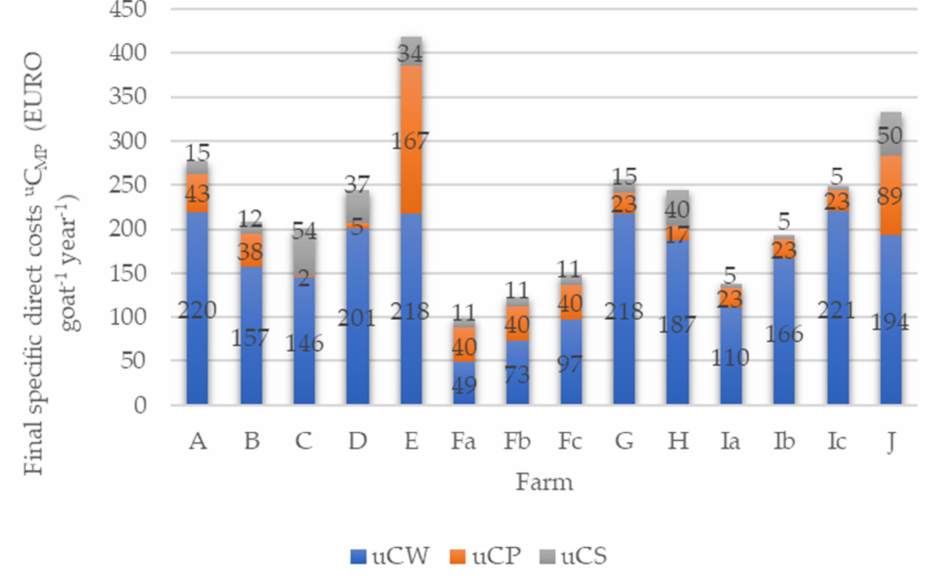
Figure 4. Final specific direct costs of milking u C MP (EUR goat − 1 year − 1 ) in the milking parlors in the current situation at all goat farms ( u C W —specific labor costs (EUR goat − 1 year − 1 ); u C P —specific costs of the milking equipment (EUR goat − 1 year − 1 ); u C S —specific costs of consumed supplies (EUR goat − 1 year − 1